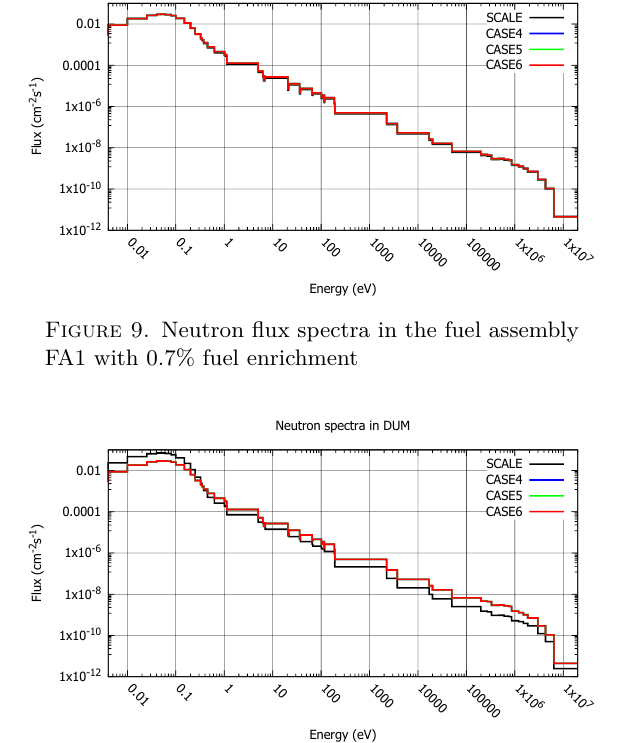
Figure 10. Neutron flux spectra in the DUM with 0.7% fuel enrichment